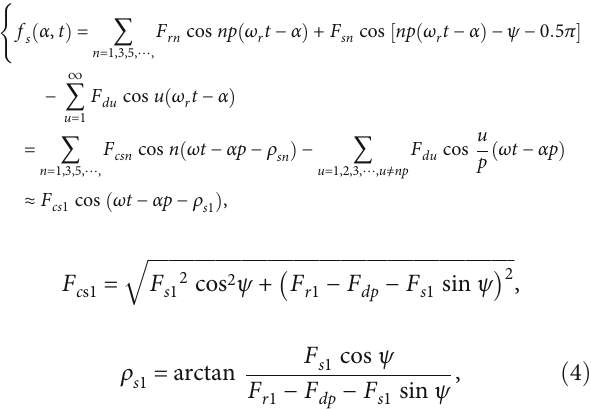
Figure 3: Diagram of fundamental MMF vectors ( F represent the base harmonic of summed MMF in normal and